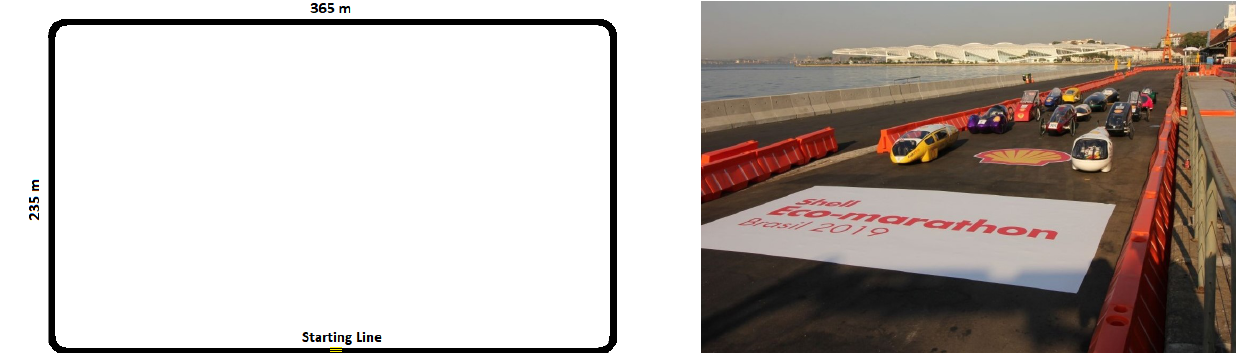
Figure 1. Circuit diagram and image of the Brazilian start line for the Shell Eco-marathon competition (5 m wide rectangular circuit with 90 ◦ curves with an 8 m